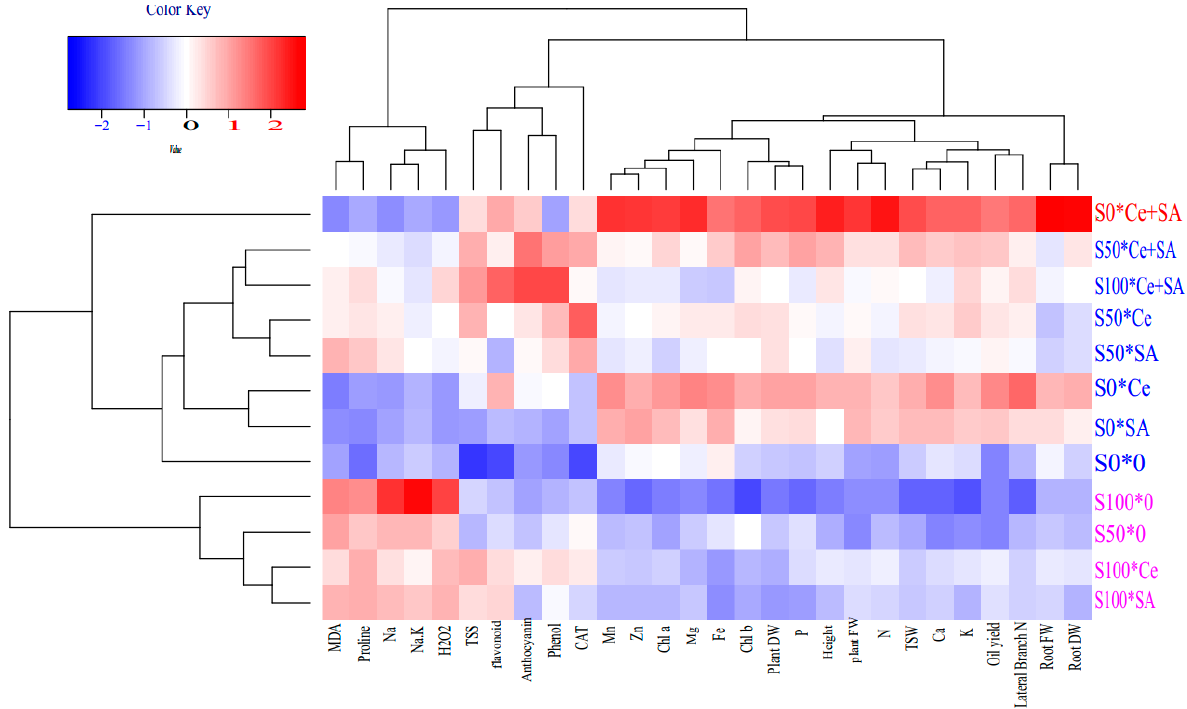
Figure 2. Heat map of the cluster analysis dendrogram for the effects of NaCl salinity and foliar applications (distilled water, salicylic acid, cerium oxide nanoparticles, and CeO 2 :SA-nanoparticles) on the growth, physiological responses, and elemental content in Portulaca oleracea plants. FW & DW refers to fresh and dry weight, respectively.